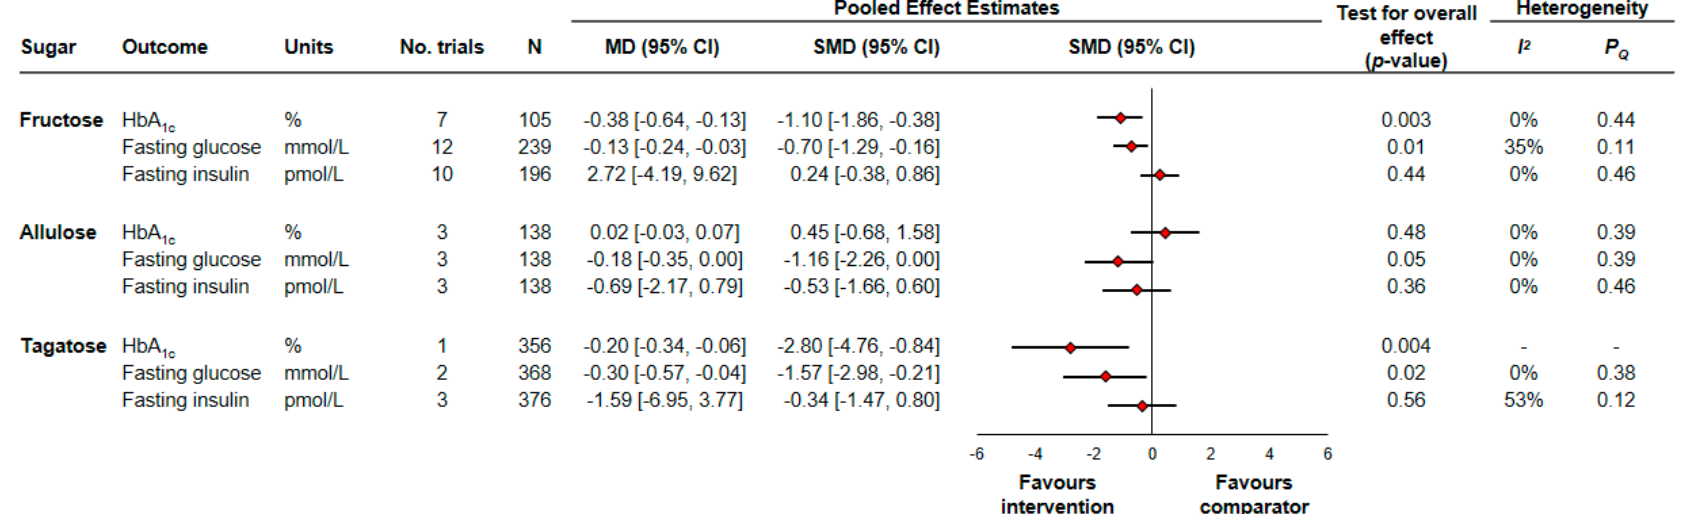
Figure 2. Summary of the pooled effect estimates from controlled feeding trials assessing the effect of small doses of fructose, allulose, and tagatose on glycemic control. To allow the summary estimates for each endpoint to be displayed on the same axis, mean differences (MDs) were transformed to standardized mean differences (SMDs) and pseudo-95% confidence intervals (CIs), which were derived directly from the original mean difference and 95% CI. N, number of participants.